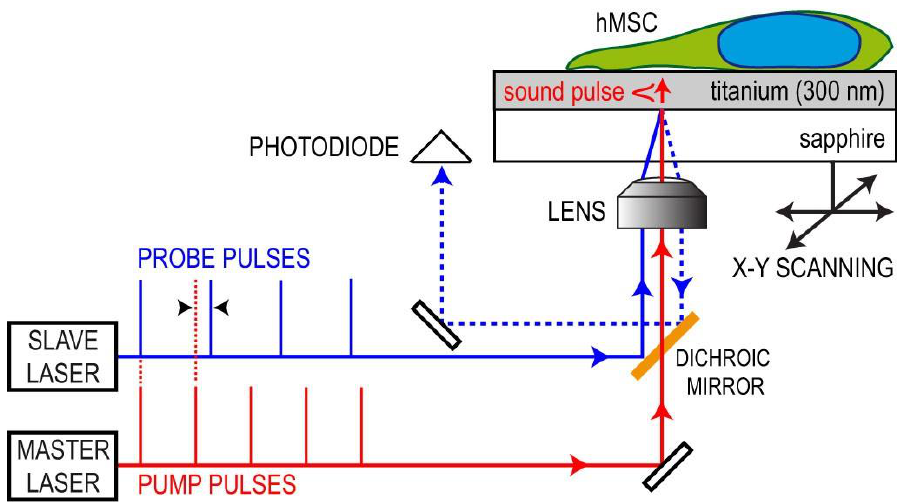
Figure 18. Side-view of the inverted pulsed opto-acoustic microscope (iPOM). Two lasers are used with a slightly different repetition rate to generate broadband acoustic waves and detect echoes in the Ti transducer by optical sampling. (hMSC—human mesenchymal stem cells) (Reproduced with permission from [209] under Creative Commons Attribution 4.0 International